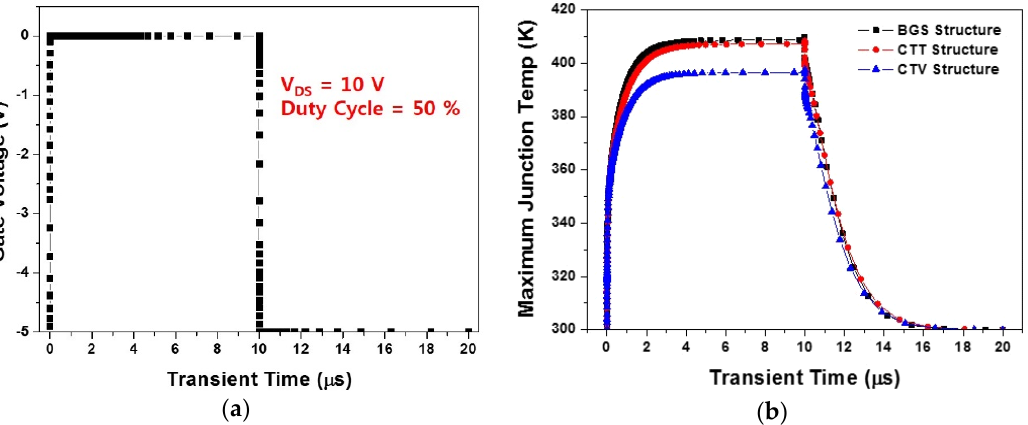
Figure 11. Transient thermal responses in the BGS, CTT, and CTV structures under 50% duty cycle: ( a ) Transient bias condition with a 50% duty cycle and ( b ) transient maximum junction temperature as a function of time.